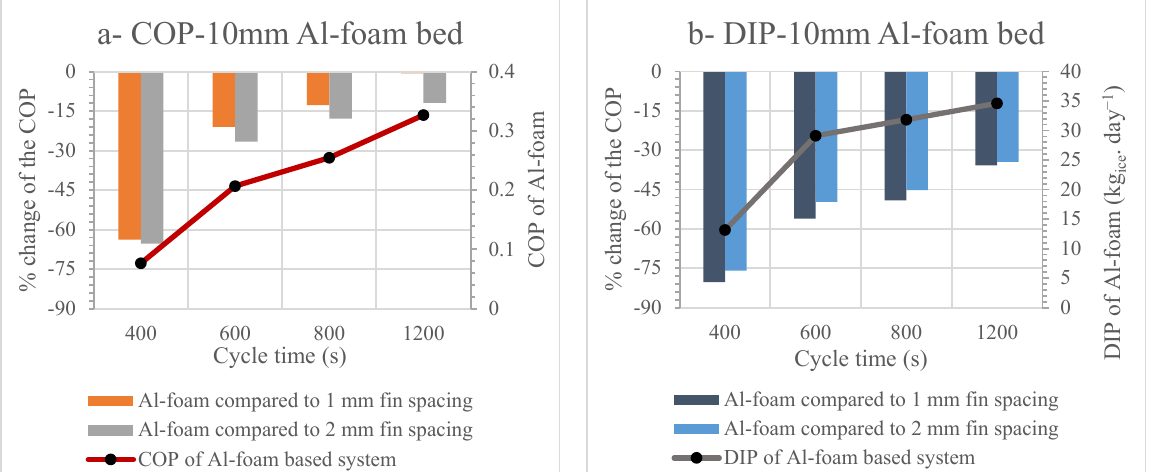
Figure 10. Effect of the cycle time on the percentage change in the system COP and DIP when using Al-foam bed with 10 mm thickness. ( a ) COP, ( b )